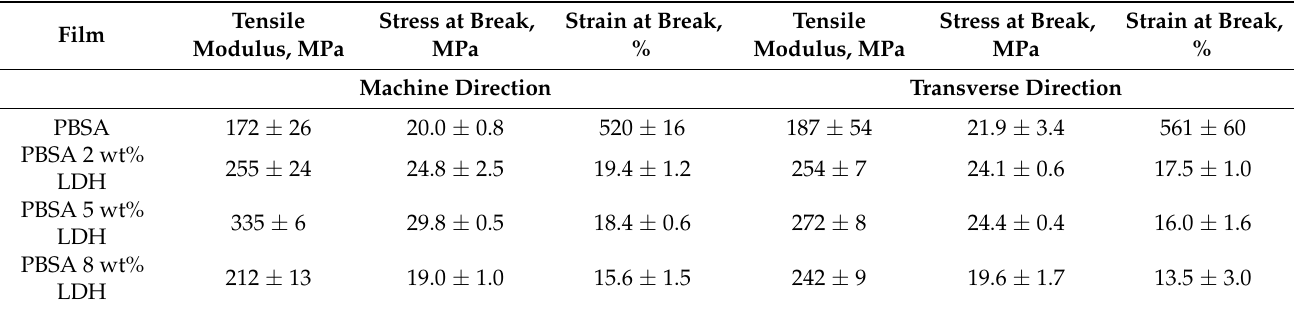
Table 2. Tensile properties of PBSA and PBSA-LDH films in machine and transverse directions. Testing speed used was 30 mm min − 1